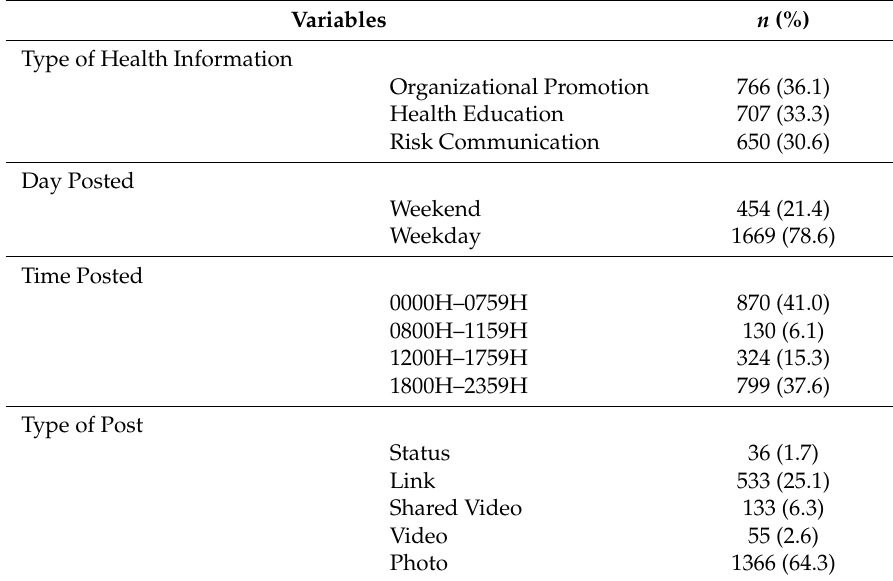
Table 1. Characteristics of posts on the Ministry of Health Facebook (MOH FB) page ( n = 2123).